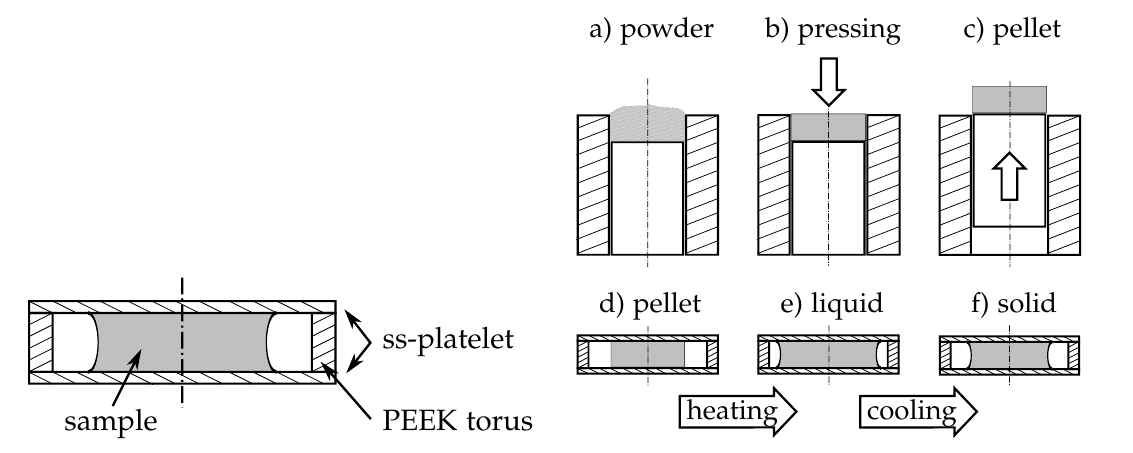
Figure 2: Sketch of the LFA sample holder. Figure 3: Steps of the sample preparation for the LFA measure- Figure 1: Sketch of the 3-layer-calorimeter. Figure 3. Sketch of the LFA sample holder ( left ) and steps of the sample preparation for the LFA measurements ( right